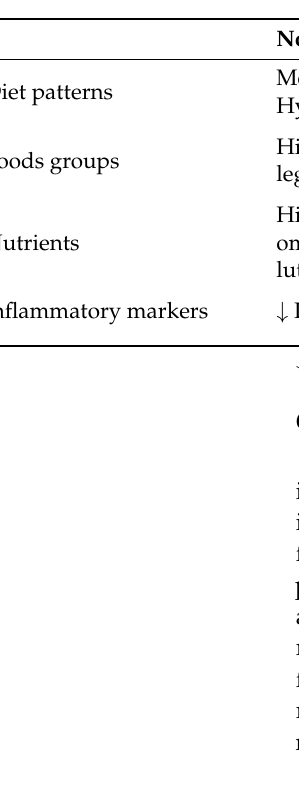
Table 1. Pro-inflammatory and anti-inflammatory effect of diet in